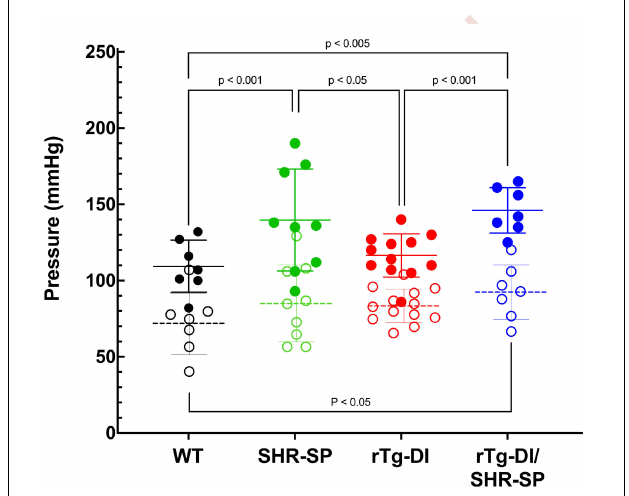
FIGURE 1 | Bigenic rTg-DI rats exhibit elevated blood systolic pressure at 7 M of age. Systolic (closed circles) and diastolic (open circles) blood pressure readings were measured in WT (black; n = 7), SHR-SP (green; n = 9), rTg-DI (red; n = 12), and bigenic rTg-DI/SHR-SP (blue; n = 7) rats at 7 M of age. Mean pressures are represented by solid or hashed horizontal lines ± SD. The systolic blood pressures of SHR-SP and rTg-DI/SHR-SP rats are significantly increased from those of WT and rTgDI rats. One-way ANOVA shows P < 0.001 between SHR-SP and WT, P < 0.05 between SHR-SP and rTg-DI, P < 0.005 between bigenic rTg-DI/SHR-SP and WT, and P < 0.001 between bigenic rTg-DI/SHR-SP and rTg-DI. These results indicate that increased systolic blood pressure is preserved with addition of the rTg-DI transgene on the SHR-SP